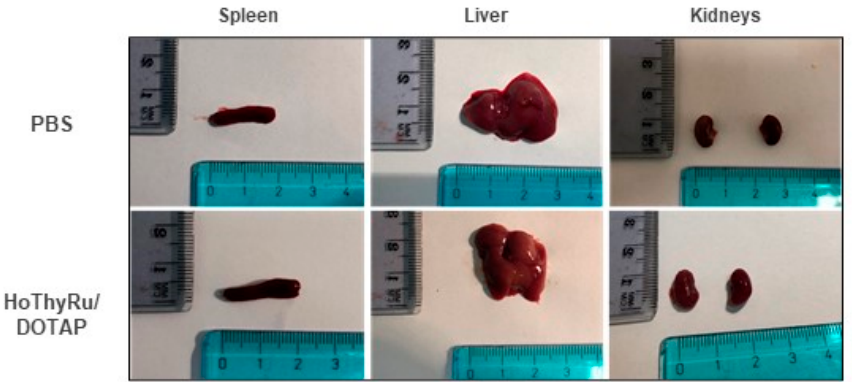
Figure 5. Representative images of spleen, liver and kidneys isolated for autopsy analysis at the endpoint of the preclinical study from control (PBS) and treated mice (HoThyRu/DOTAP, 15 mg/kg, i.p. , once a week for 4 weeks).